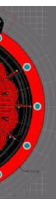
Figure 24 Structure of AFPMSM with hybrid PCB coil